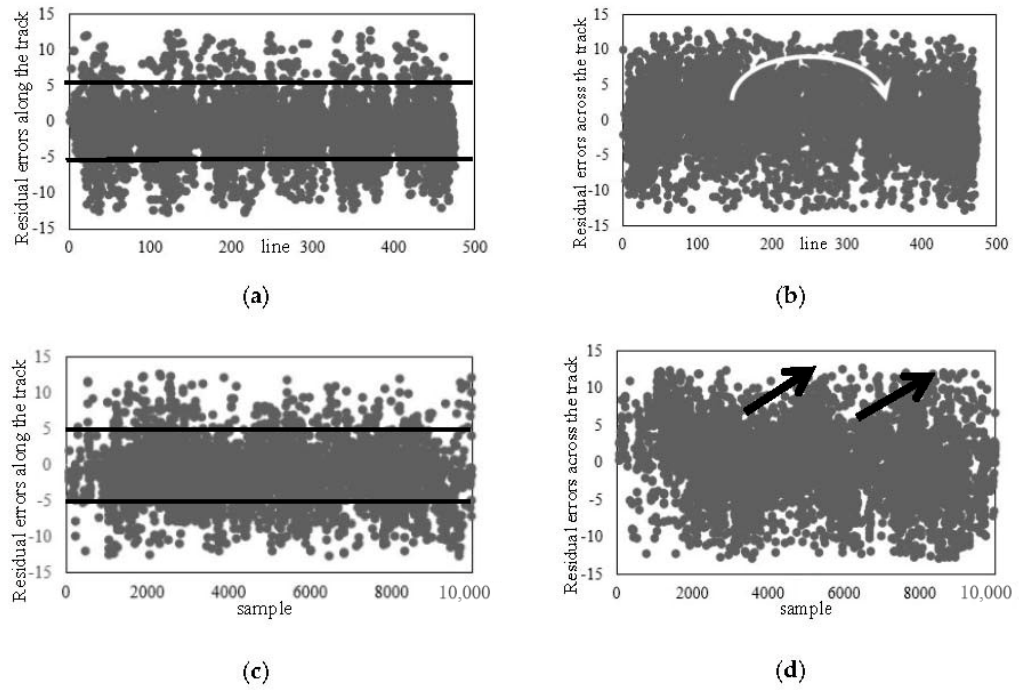
Figure 7. Residual errors after external calibration: ( a ) Residual errors along the track (flight direction); ( b ) residual errors across the track (flight direction); ( c ) residual errors along the track (whiskbroom direction); ( d ) residual errors across the track (whiskbroom direction).